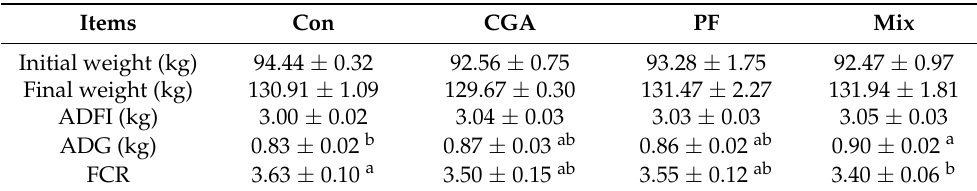
Table 2. Effects of L. japonica crude extract and Radix Puerariae crude extract on the growth perfor- mance of finishing